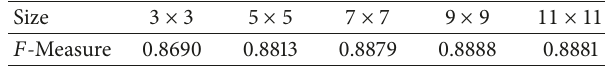
Table 2: Performance of proposed method with postprocessing. Size 3 × 3 5 × 5 7 × 7 9 × 9 11 × 11 𝐹 -Measure 0.8690 0.8813 0.8879 0.8888